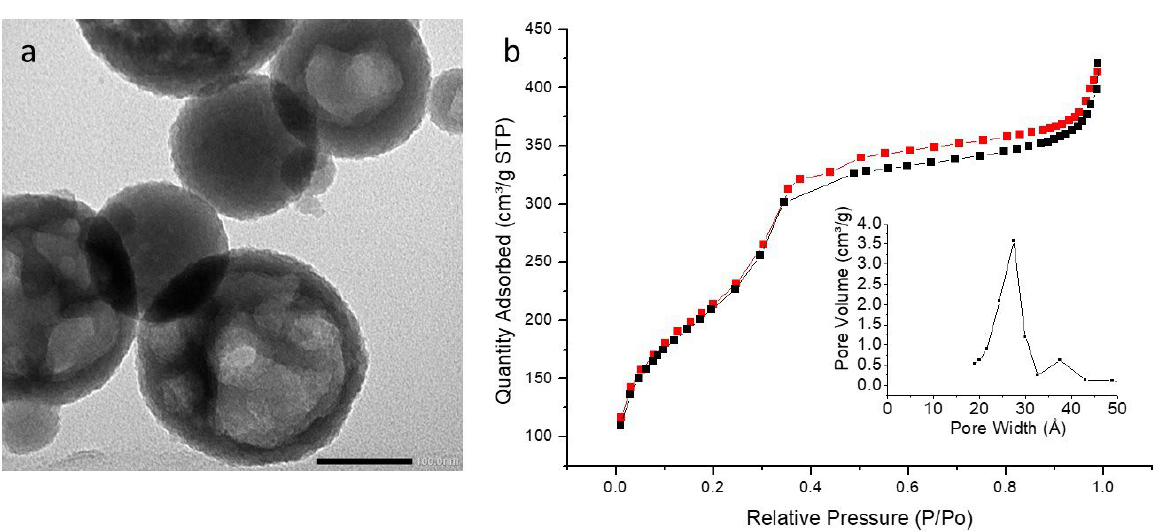
Figure 9. ( a ) TEM image of iPrbiPyPMO 10 scale bar 100 nm. ( b ) Nitrogen adsorption–desorption at 77 K. Insert BJH desorption (dV/dlog(w)) Pore Volume.